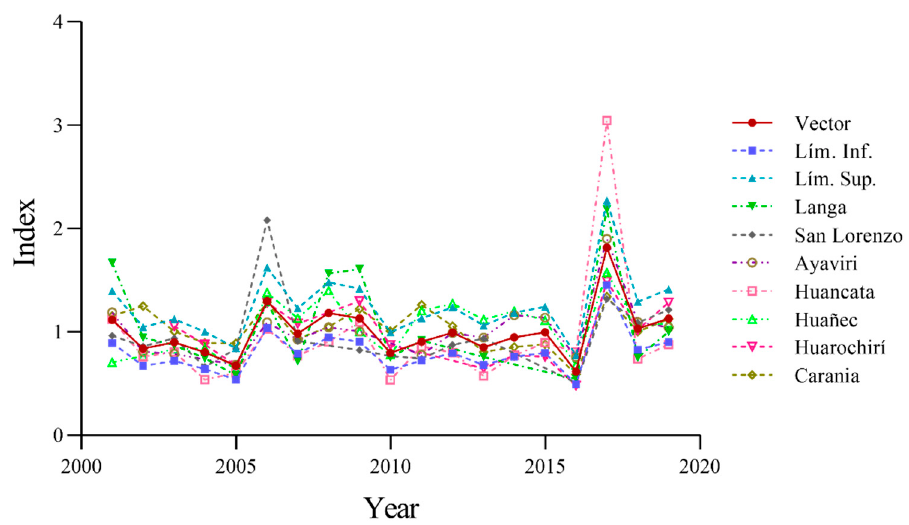
Figure 9. Annual indices of the regional vector and stations in Region 1.